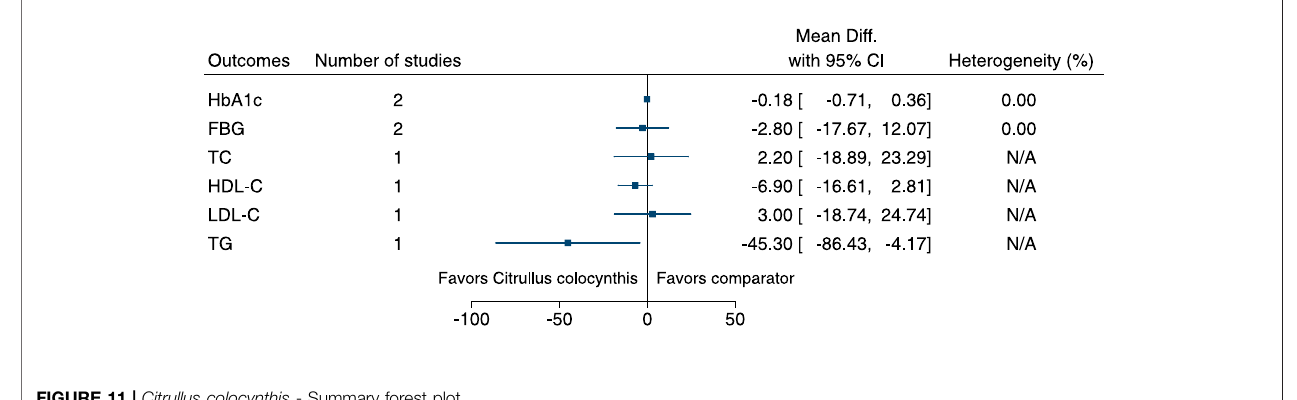
FIGURE 11 | Citrullus colocynthis - Summary forest plot.